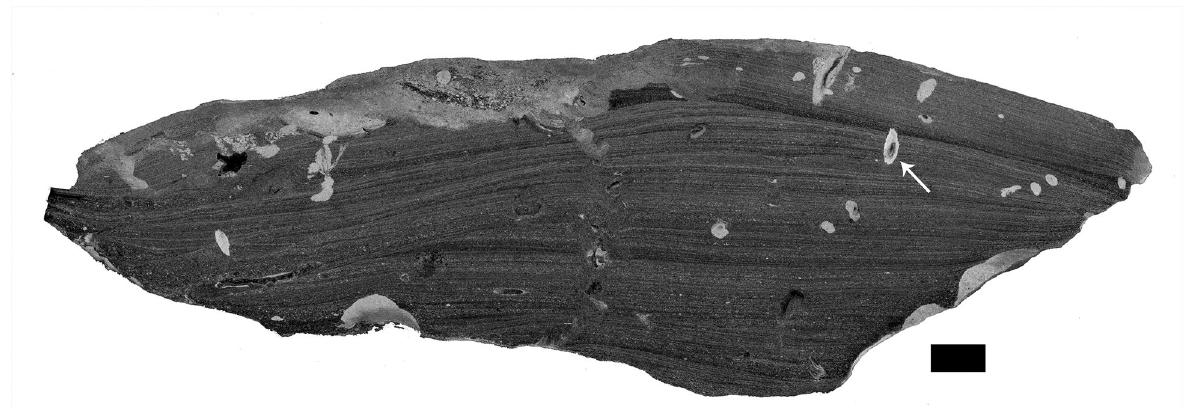
Fig. 4. Polished section of a gutter cast found within the trilobite-bearing shale unit. The image clearly shows the strong hummocky stratification. The white arrow indicates Lingulichnus escape traces. The scale bar is 1